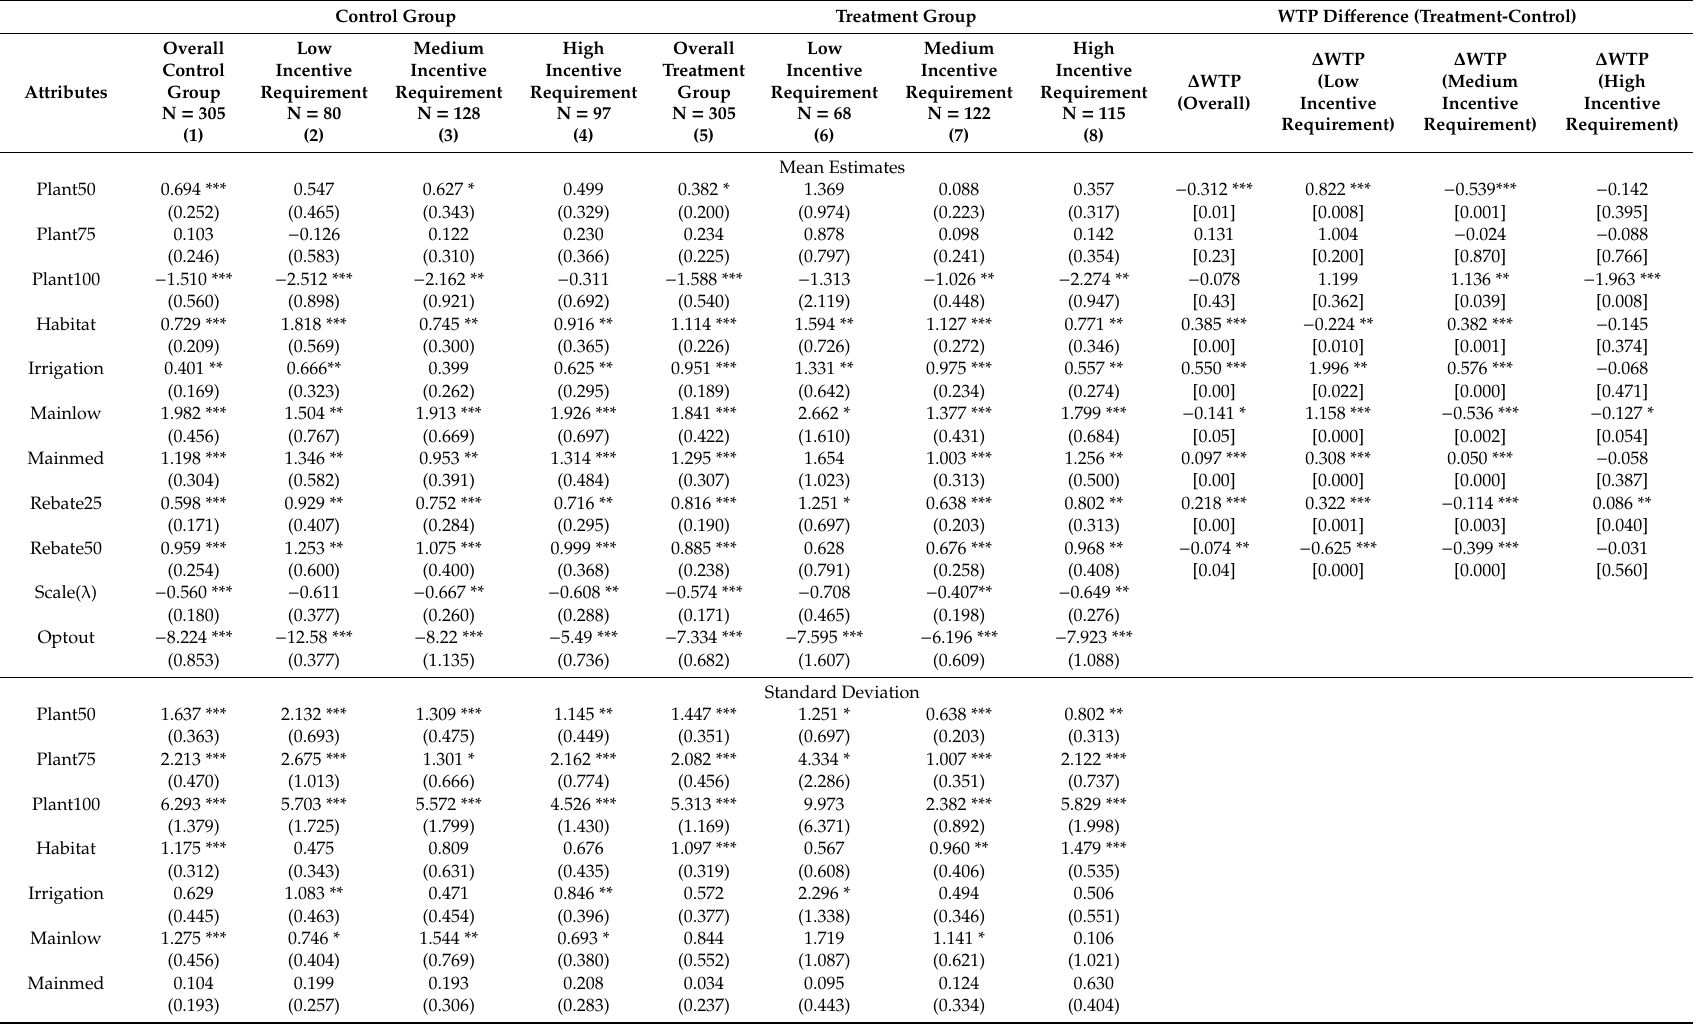
Table 3. Homeowners’ willingness to pay for environmentally friendly landscapes attributes, by monetary incentive